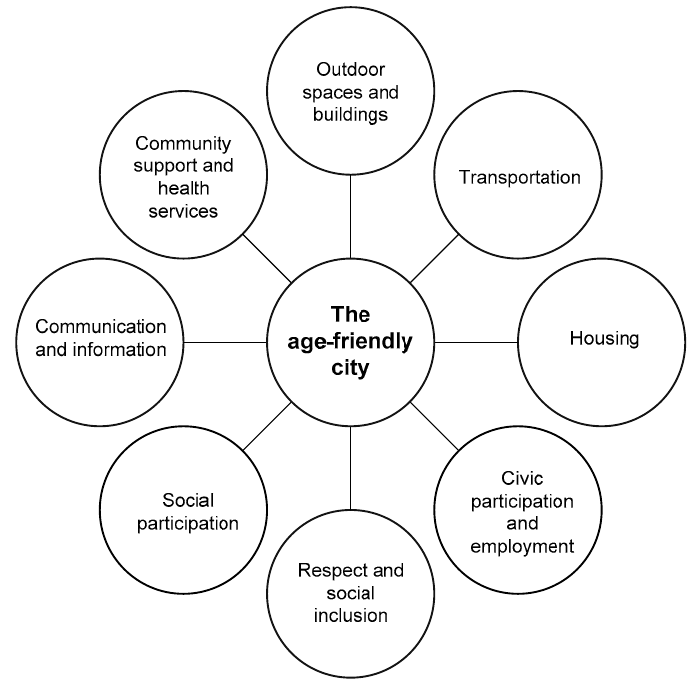
Figure 3. The eight domains of an age-friendly city [9].